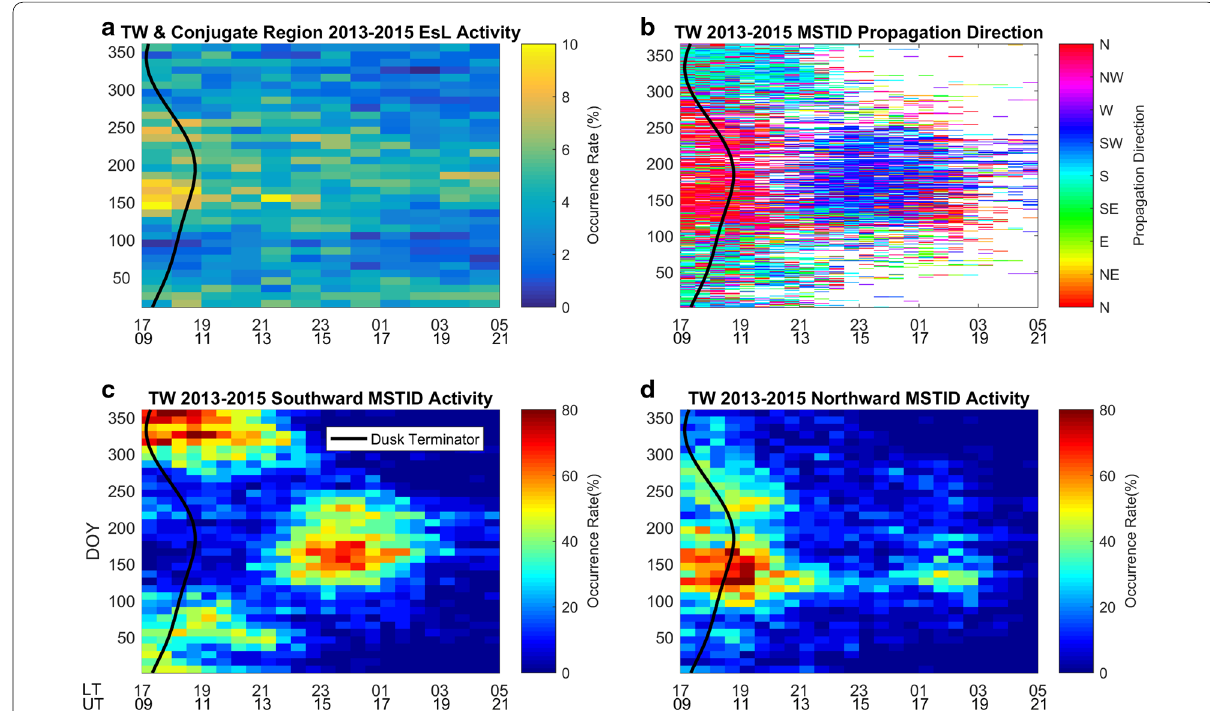
Fig. 7 Comparison of occurrences of EsL observed by FORMOSAT‑3/COSMIC and MSTIDs. a The occurrence rate of EsL detected by FORMOSAT‑3/ COSMIC RO over Taiwan and the conjugate region of Taiwan in nighttime during 2013–2015. b The propagation direction of MSTIDs over Taiwan in nighttime during 2013–2015. c The occurrence rate of southward MSTIDs over Taiwan in nighttime during 2013–2015. d The occurrence rate of northward MSTIDs over Taiwan in nighttime during 2013–2015. The black lines indicate the dusk